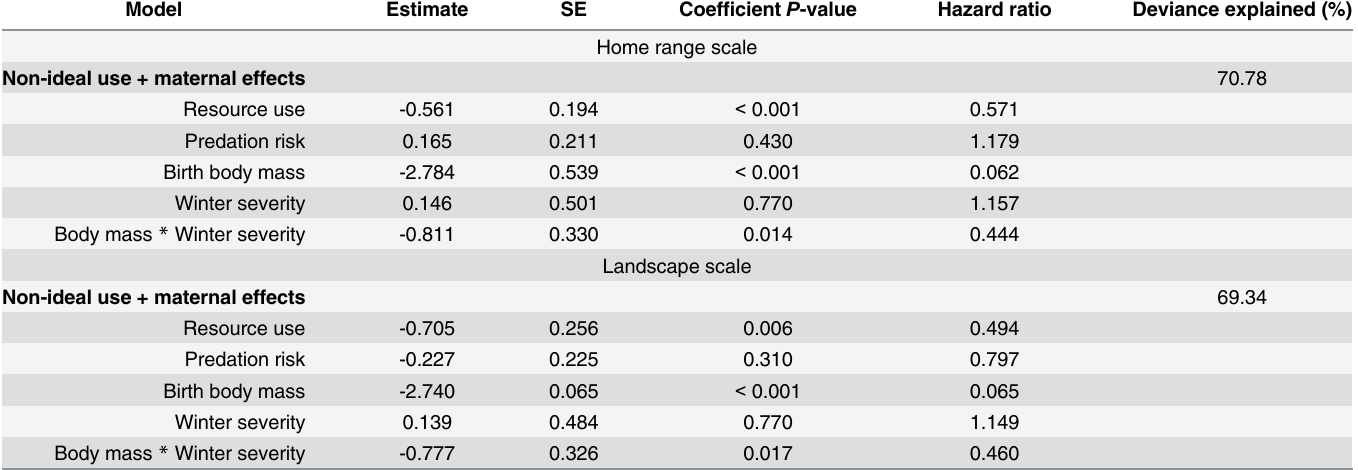
Table 5. Comparison of the best cox-proportional hazards mixed-effects models assessing the effects of resource use, predation risk, birth body mass, winter severity, and vegetation hiding cover on the daily survival of white-tailed deer fawns ( (cid:1) 14 weeks of age; n = 129) at the home range and landscape scales during the post-partum period (14 May – 31 Aug), Upper Peninsula of Michigan, USA, 2009 – 2011. Models included individual fawn and year as random effects on the intercept. Models presented with standardized parameter estimates, standard errors (SE), probability values, and estimated hazard ratio parameter probability values, and percent integrated deviance explained indicating the reduction in the log-likelihood from the null model. The home range model was available from [13].